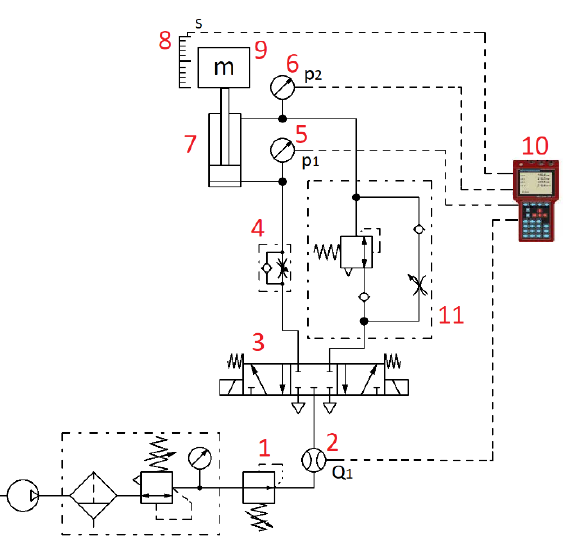
Fig. 10. The scheme of measurement with ASR pressure regulator 1 – reduction valve, 2 – flow meter, 3 –directional control valve, 4 – throttle and check valve, 5 – pressure 𝑝 6 –, pressure 𝑝 sensor 7 – pneumatic cylinder (linear motor), 2 8 – position sensor, 9 – mass load, 10 - measuring equipment M5050, 11 – ASR pressure regulator sensor, 1 Tab. 4. Comparison of each method to determine